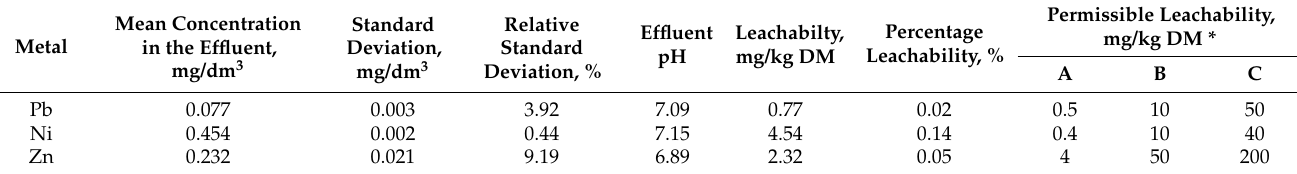
Table 9. Results of leaching of Pb(II), Ni(II), and Zn(II) from Pliocene clays after sorption. Mean Concentration Metal in the